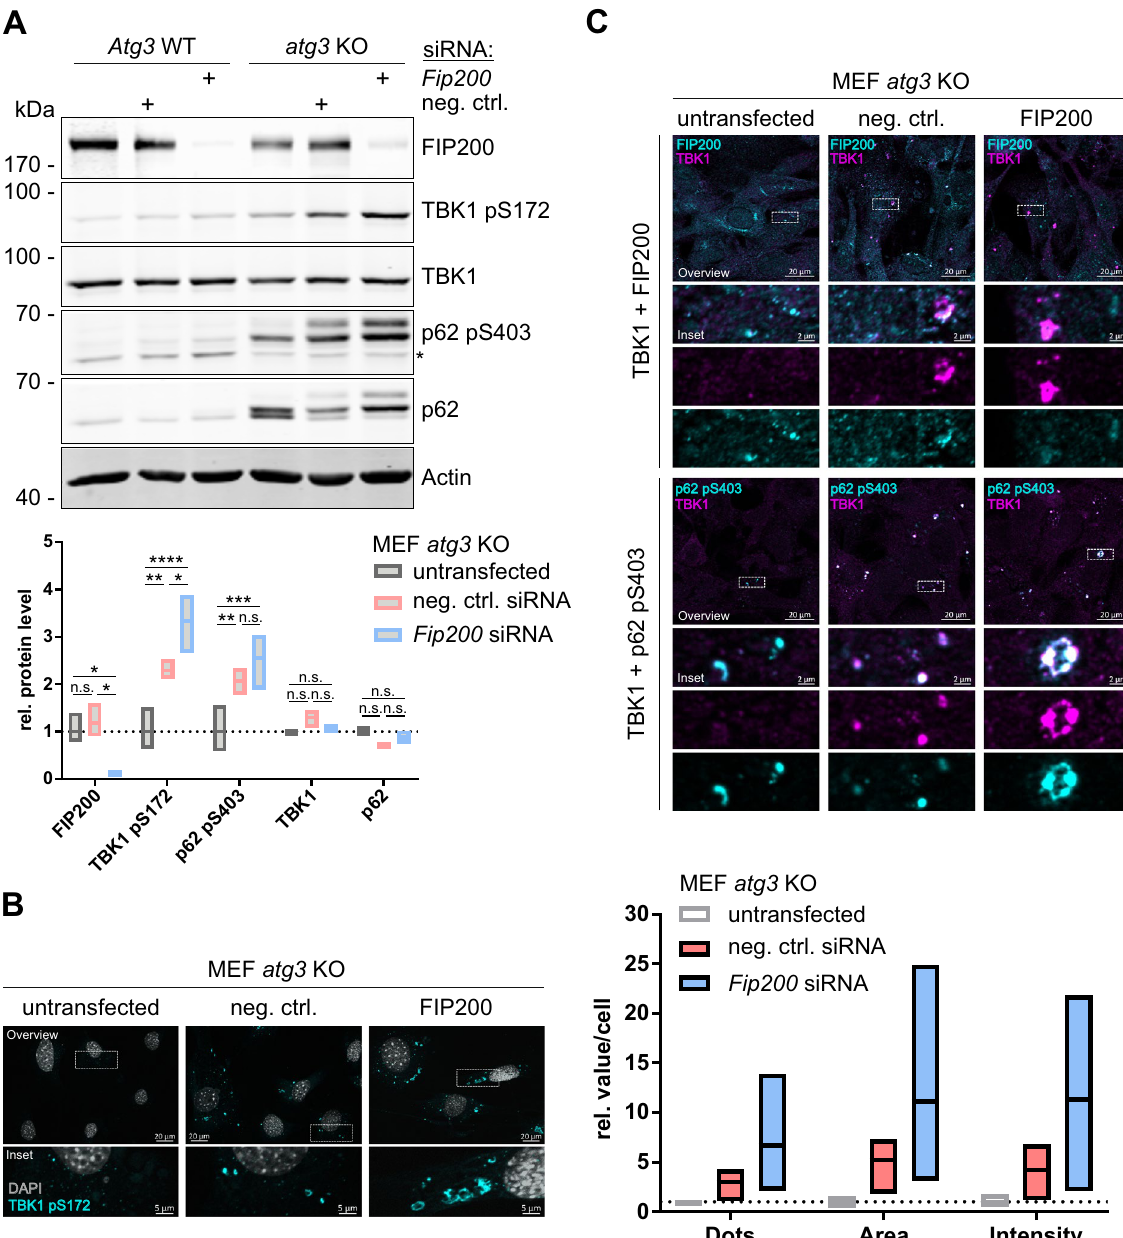
Figure 6. Loss of FIP200 further enhances TBK1 accumulation and activation caused by defective autophagy. ( A ) Atg3 WT and atg3 KO MEFs were transfected with either 20 nM negative control siRNA or 20 nM Fip200 siRNA for 72 h, and the cleared cellular lysates were immunoblotted for the indicated proteins. The asterisk indicates a nonspecific band. The full-length blots are presented in Figure S9. The densities of the bands on immunoblots from three independent experiments were quantified and normalized to those of Actin. For each protein, the normalized densities of atg3 KO samples were normalized to that of the respective untransfected sample. The boxes represent the highest and the lowest value, while the centerline shows the mean. Two- way ANOVA with Tukey’s multiple comparisons test was used to determine differences between treatments. n.s. = not significant; *p < 0.05; **p < 0.01; ***p < 0.001; ****p < 0.0001. ( B + C ) atg3 KO MEFs were transfected with either 20 nM negative control siRNA or 20 nM Fip200 siRNA for 72 h and immunostained for TBK1 pS172 (B; fixed in 4% PFA) or TBK1 in combination with either FIP200 or SQSTM1/p62 pS403 ( C ; fixed in 100% MeOH). For ( B ), the number, area, and intensity of TBK1 pS172-positive structures of at least 232 cells per cell line were quantified using ImageJ 1.53c and normalized to those of untransfected atg3 KO cells. The boxes represent the highest and the lowest value, while the centerline shows the mean from four independent experiments. For IF imaging, DAPI was used to stain